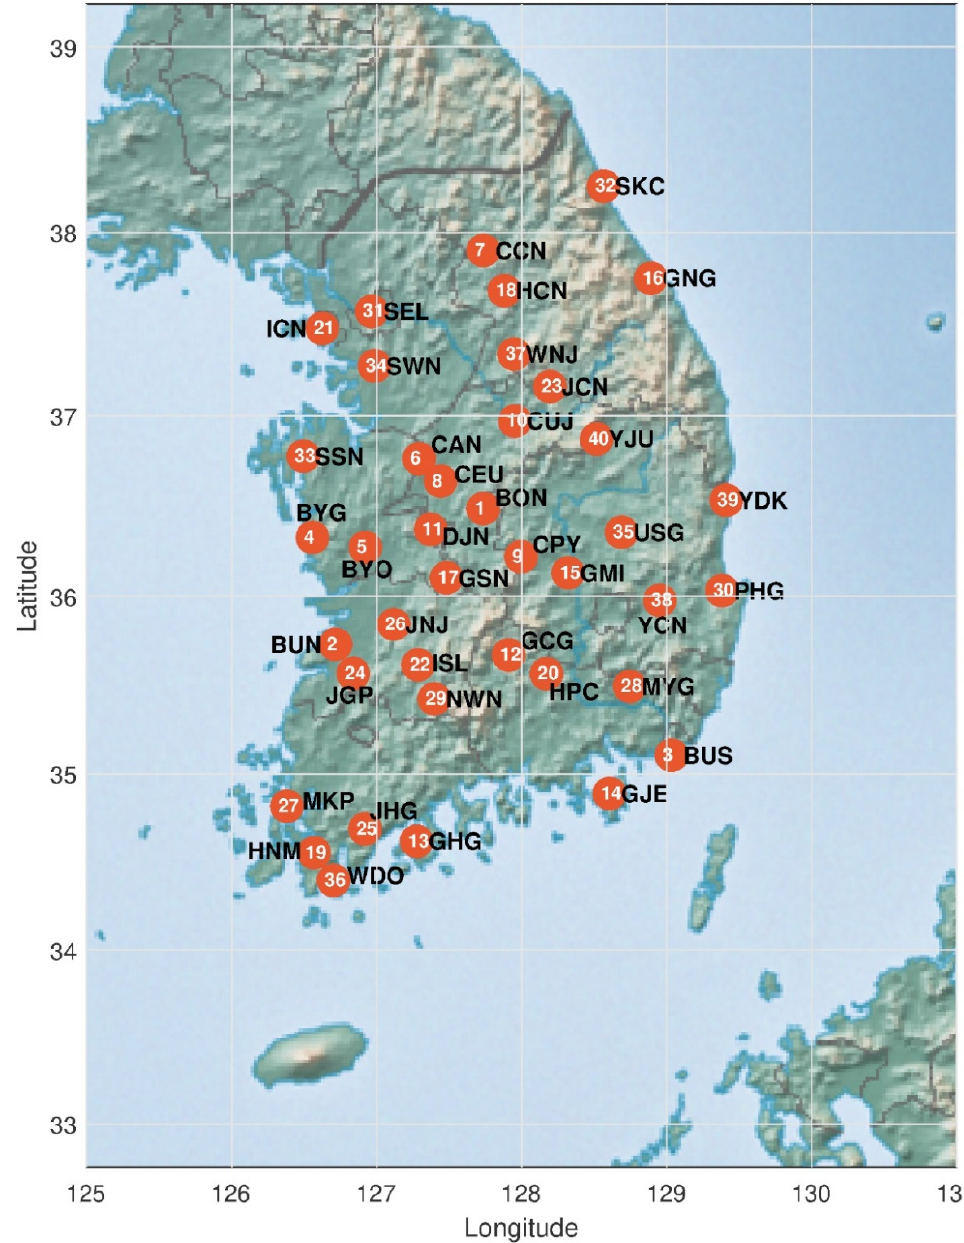
Figure 2. Spatial map of 40 stations across South Korea. The name, latitude, and longitude of each location are given in Table S1 in the Supplementary Materials.